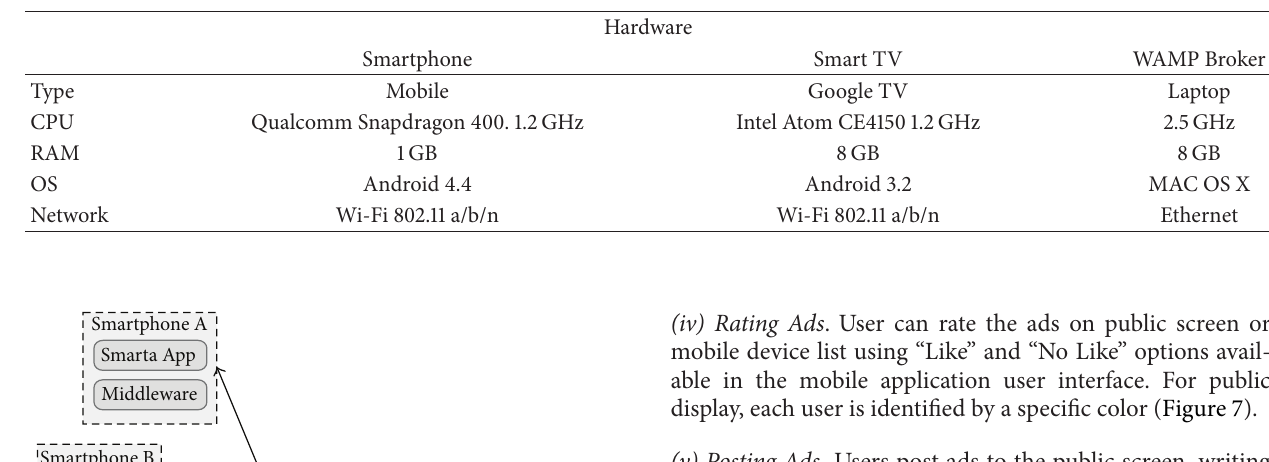
Table 4: Offline tests hardware setup.